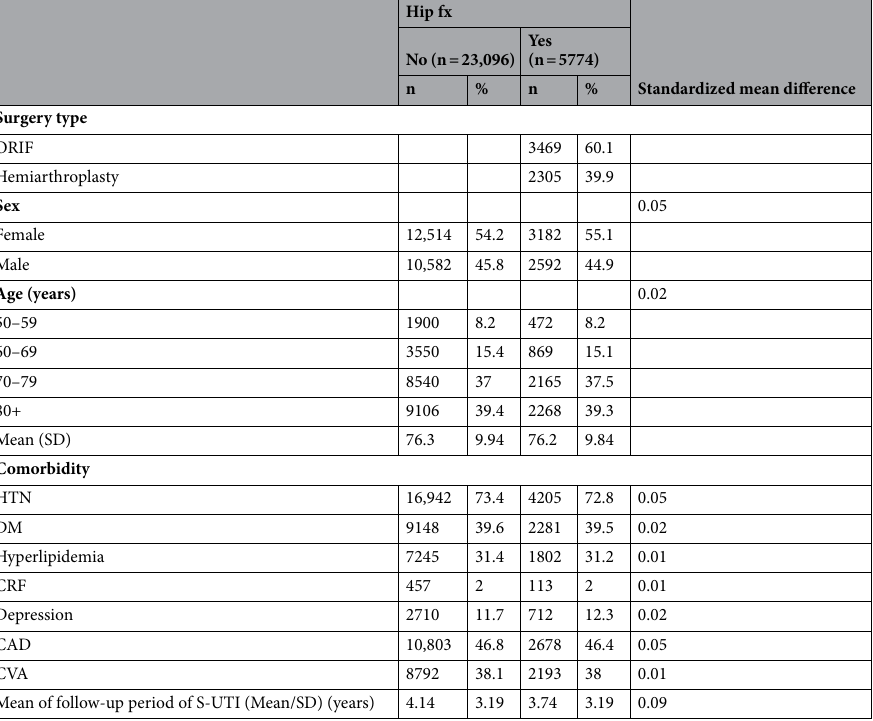
Table 1. Baseline characteristics in study cohorts with hip fx undergoing surgery and without hip fx. A standardized mean difference ≤ 0.10 indicates a negligible difference between the two cohorts. CAD coronary artery disease, CRF chronic renal failure, CVA cerebrovascular accident, DM diabetes mellitus, Fx fracture, HTN hypertension, ORIF open reduction and internal fixation, S-UTI severe urinary tract